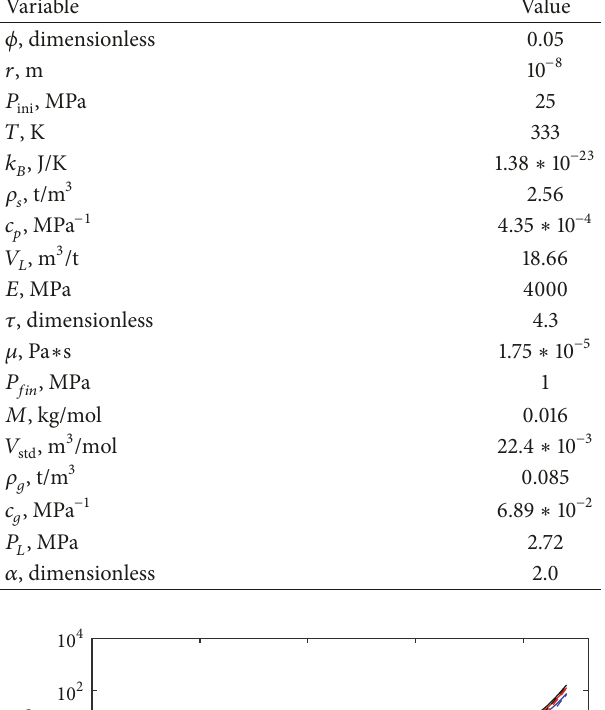
Table 2: Basic parameters.